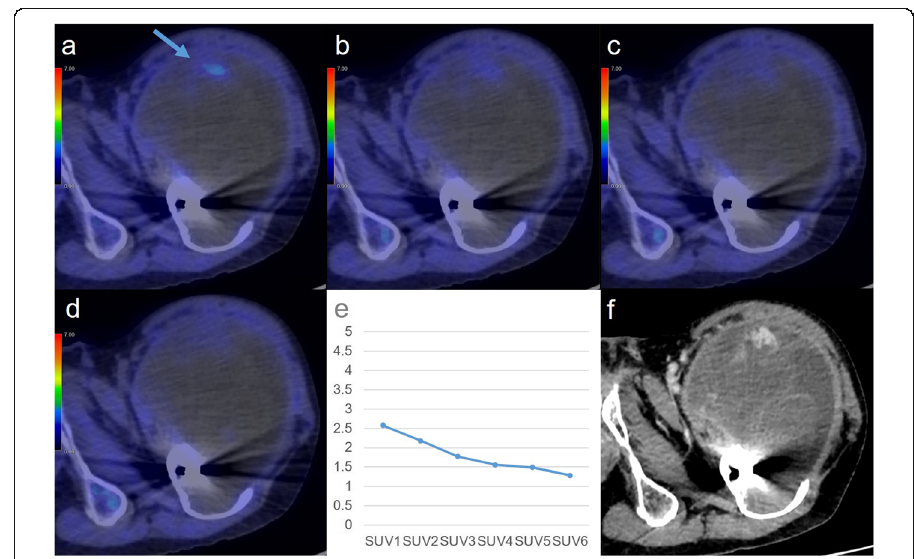
Fig. 2 A 67-year-old man with chronic expanding haematoma in the right femur. Dynamic positron- emission tomography/computed tomography (PET/CT) ( a – d ) images are shown. In the dynamic first